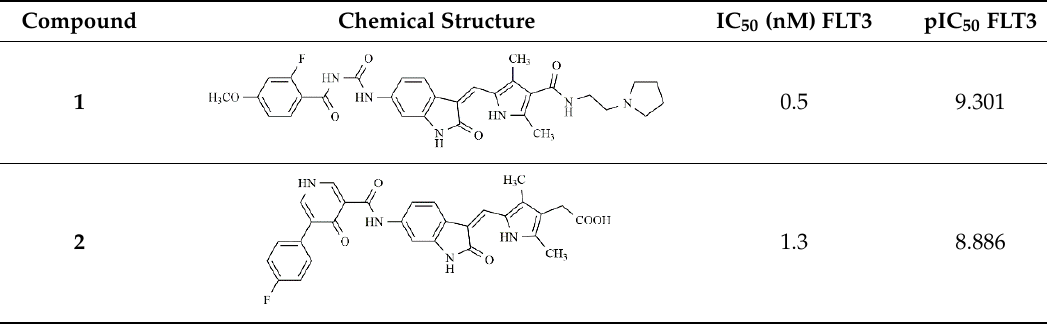
Table 1. Chemical structures, IC 50 and pIC 50 values of 1 – 41 [11], Quizartinib and Sunitinib FLT3 inhibitor compounds. Test set compounds are marked with an asterisk.